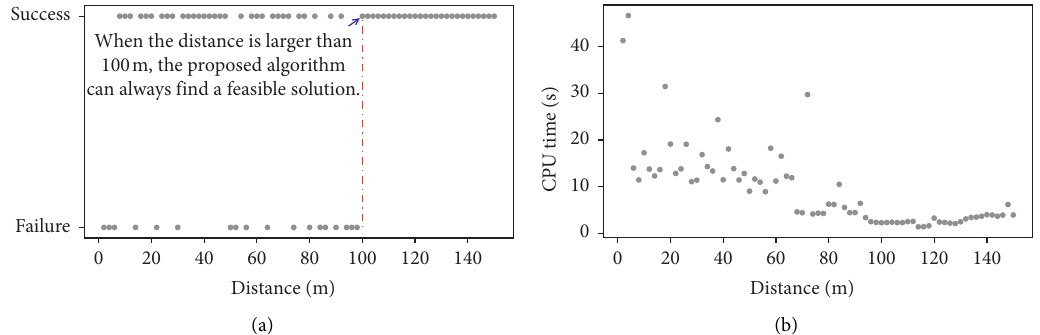
Figure 12: Effect of the distance between vehicle 0 and vehicle 3. (a) Effect of the distance on the feasibility of the algorithm. (b) Effect of the distance on the computational load of the algorithm.